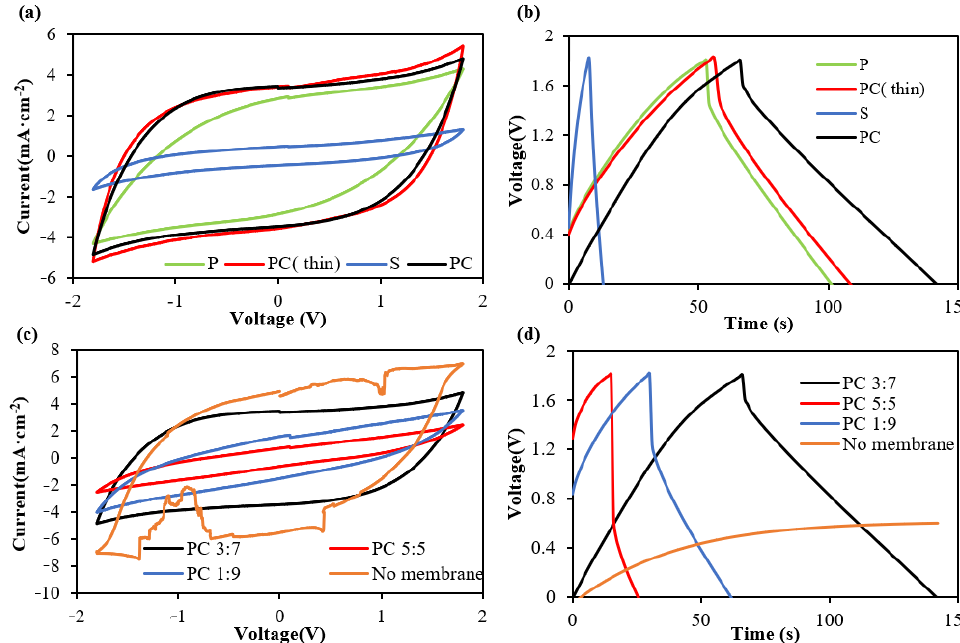
Figure 4. ( a ) CV and ( b ) GC result for single-layer textile supercapacitor based on the different textiles with an EVA:PMMA ratio of 3:7. ( c ) CV and ( d ) GC result for single-layer textile supercapacitor based on PC 1:9, PC 3:7, PC 5:5 and PC without membrane.